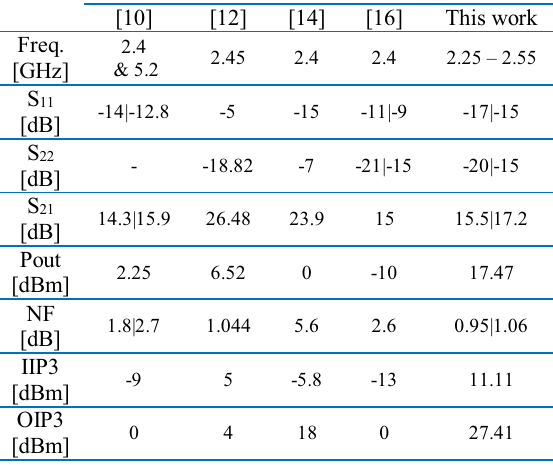
Table 2. Performances comparison of the proposed LNA with contemporary published